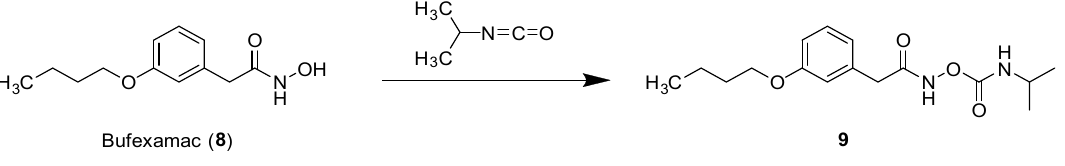
Table 3. In vitro test results of bufexamac and the carbamate 9 against the HDAC subtypes 1 and 6 (left side) and antiproliferative effects on HL60 cells (right side).